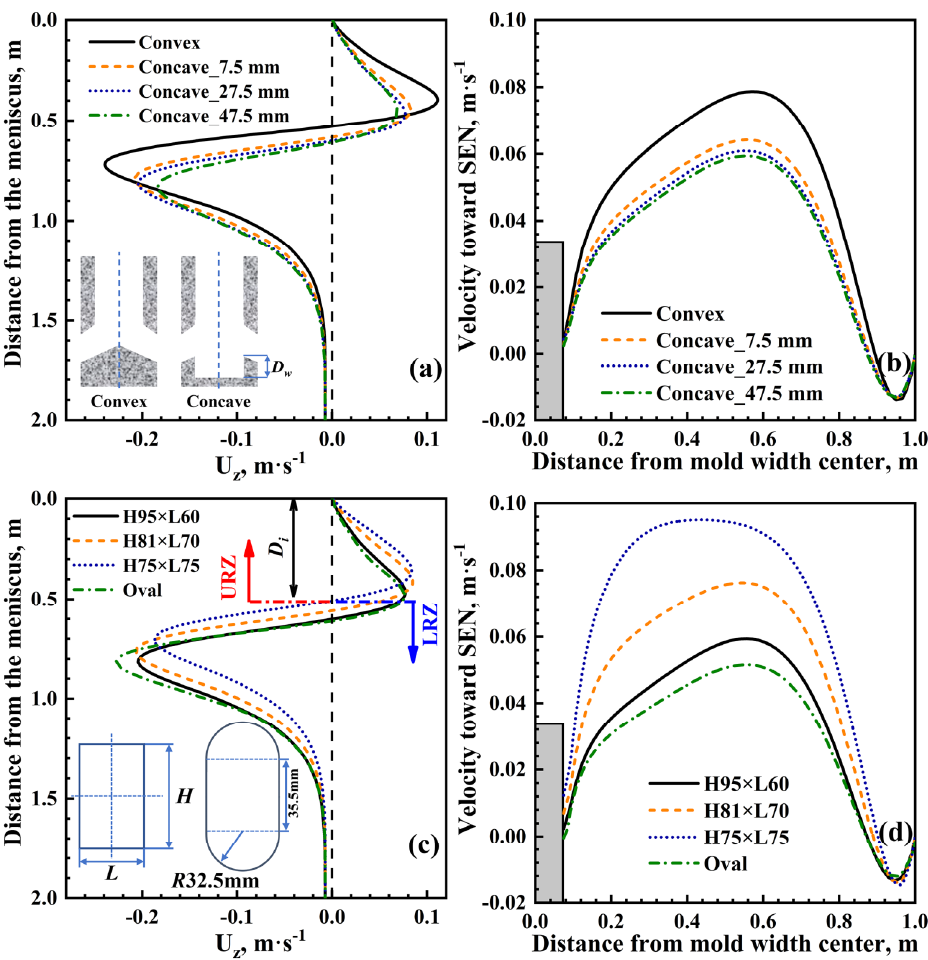
Figure 4. Longitudinal velocity profiles near NF solidification front along the casting direction ( a , c ) and horizontal velocity variations on the meniscus ( b , d ) with different SEN bottoms and port